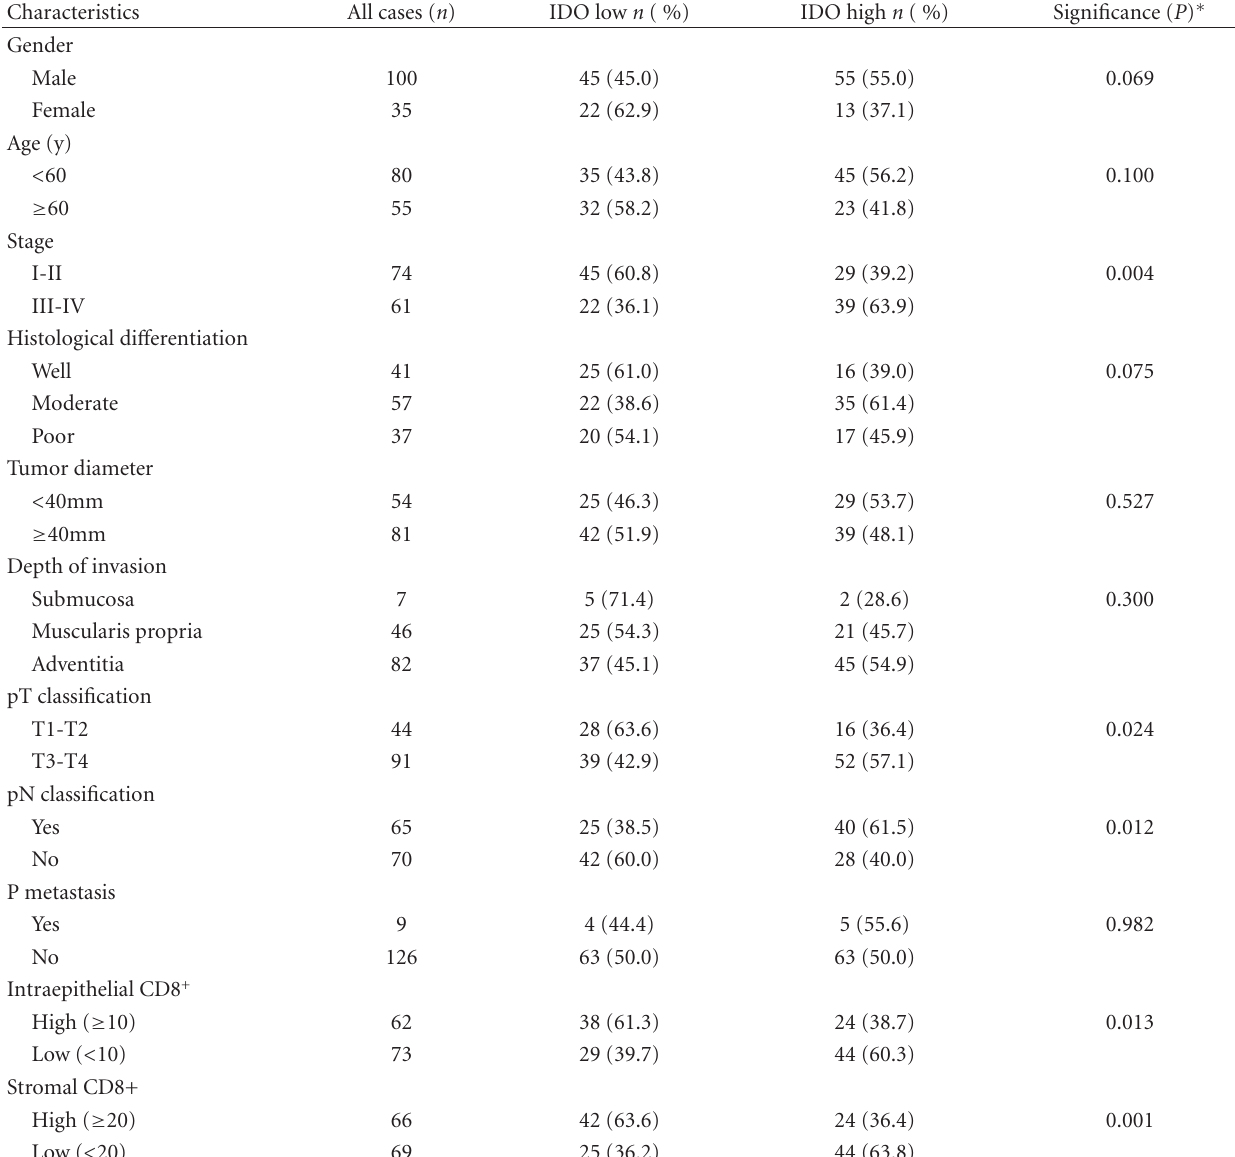
Table 1: Characteristics of 135 patients with esophageal squamous cell carcinoma and correlation between the clinicopathologic features and expression of